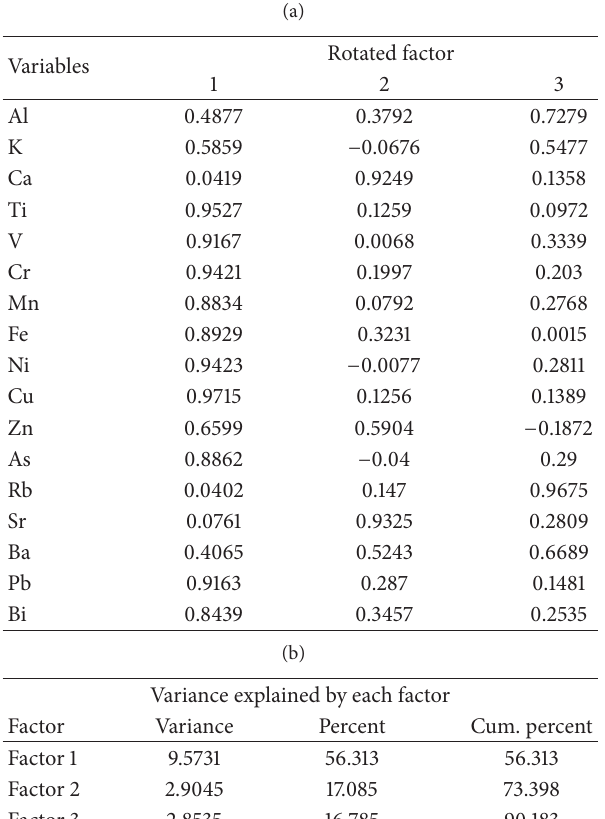
Table 4: Rotated component matrix for soil samples.